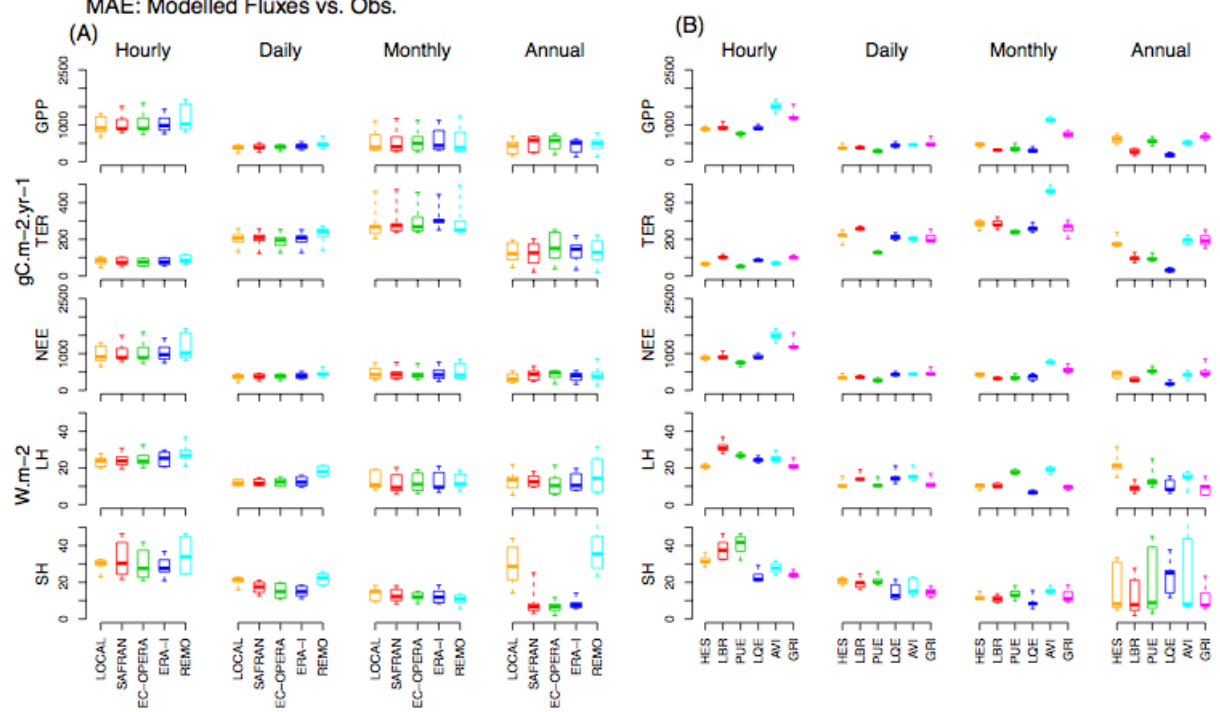
Figure 7 143 Fig. 7. Box plot of MAE between simulated and measured flux data over 2004 to 2007, except for EC-OPERA which covers only 2004–2006. (A) MAE across six sites; (B) MAE across 5 series. Columns from left to right are hourly, daily, monthly and annual means. The bottom and top of the box are the 25th and 75th percentile, respectively, and the band near the middle of the box is the median. The lower and upper ends of whiskers represent the minimum and maximum,